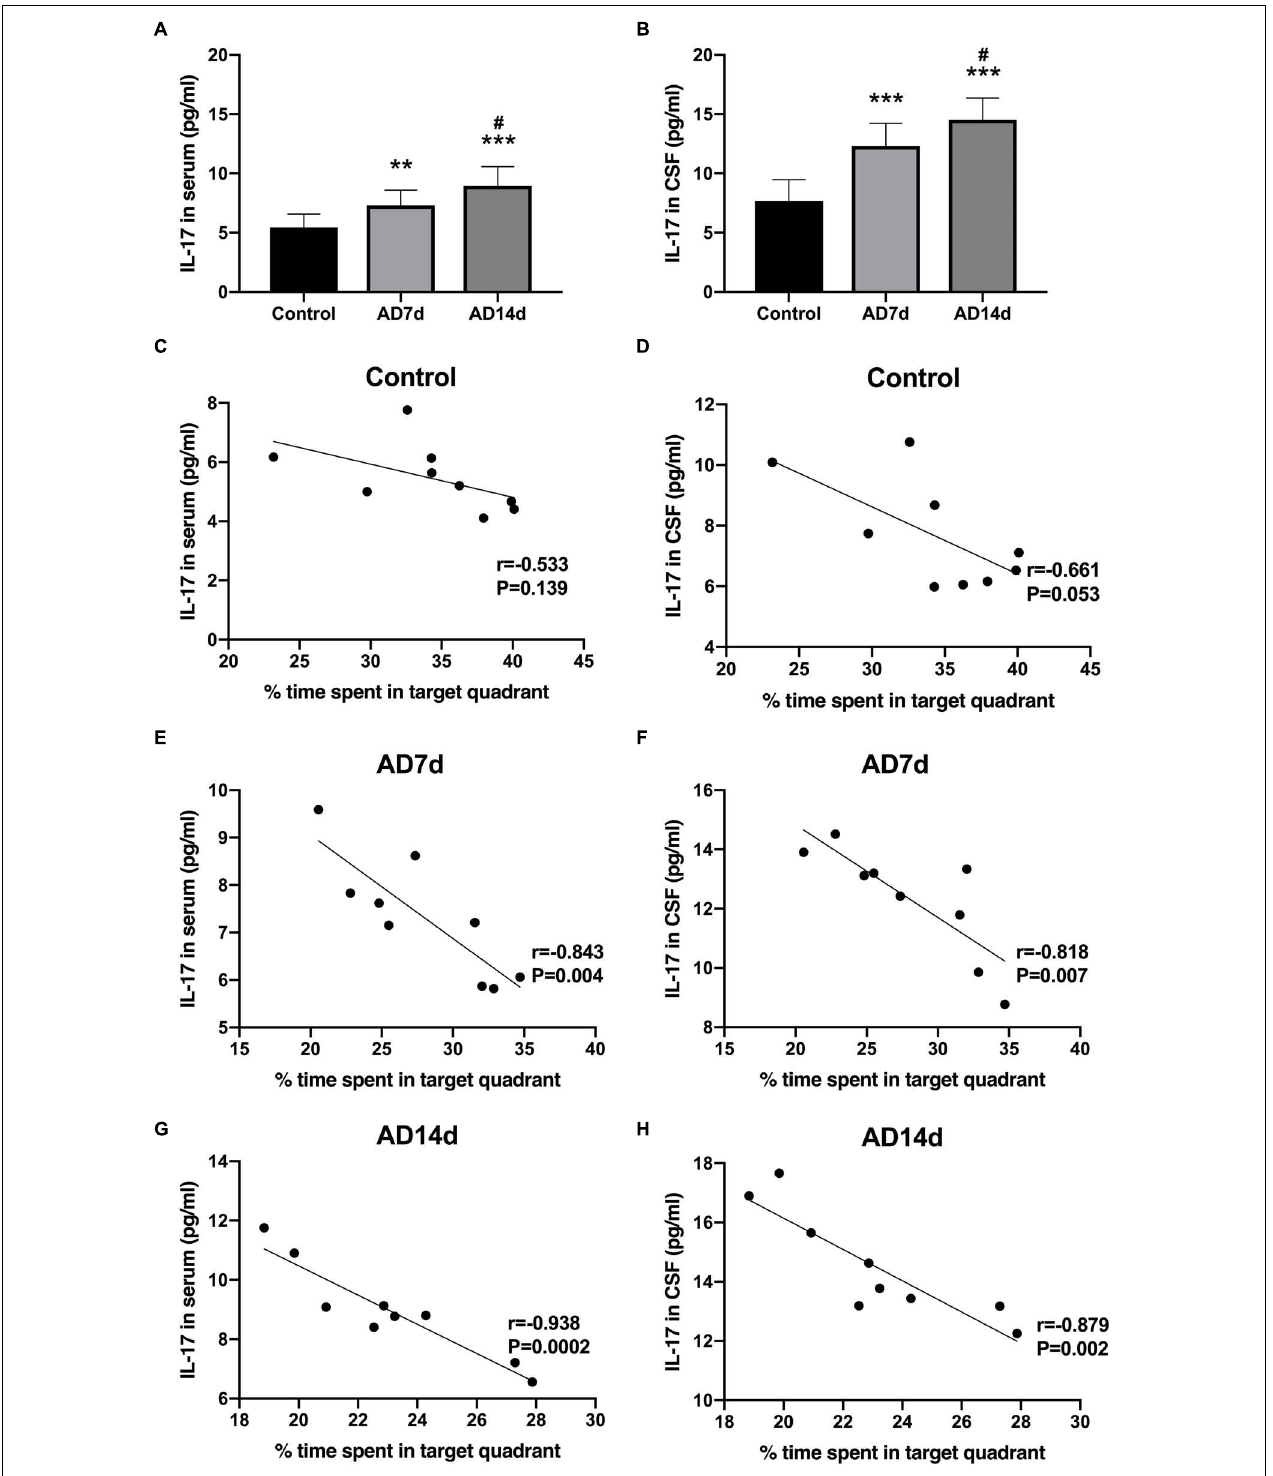
FIGURE 4 | Increased IL-17 concentrations in the serum and CSF of AD rats. IL-17 concentrations in the serum (A) and CSF (B) of the Control, AD7d, and AD14d groups were determined with use of ELISA. n = 9 per group, mean ± standard deviation, ∗∗ P < 0.01, ∗∗∗ P < 0.001 vs. Control group, # P < 0.05 vs. AD7d group. Negative correlations were obtained between serum IL-17 concentrations and percent of time in the target quadrant in the Control (C) , AD7d (E) , and AD14d (G) groups. Negative correlations were obtained between CSF IL-17 concentrations and percent of time in the target quadrant in the Control (D) , AD7d (F) , and AD14d (H)